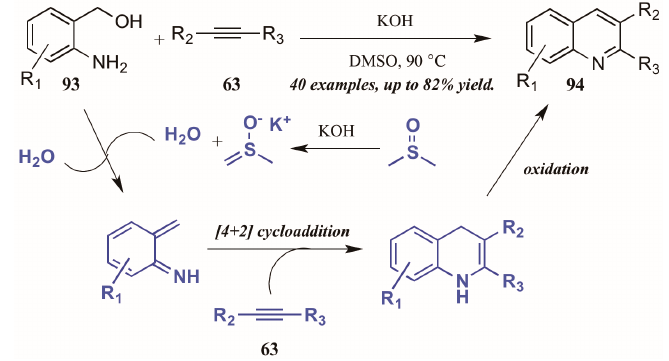
Figure 40. [4 + 2] Cycloaddition of azadienes with internal alkynes.